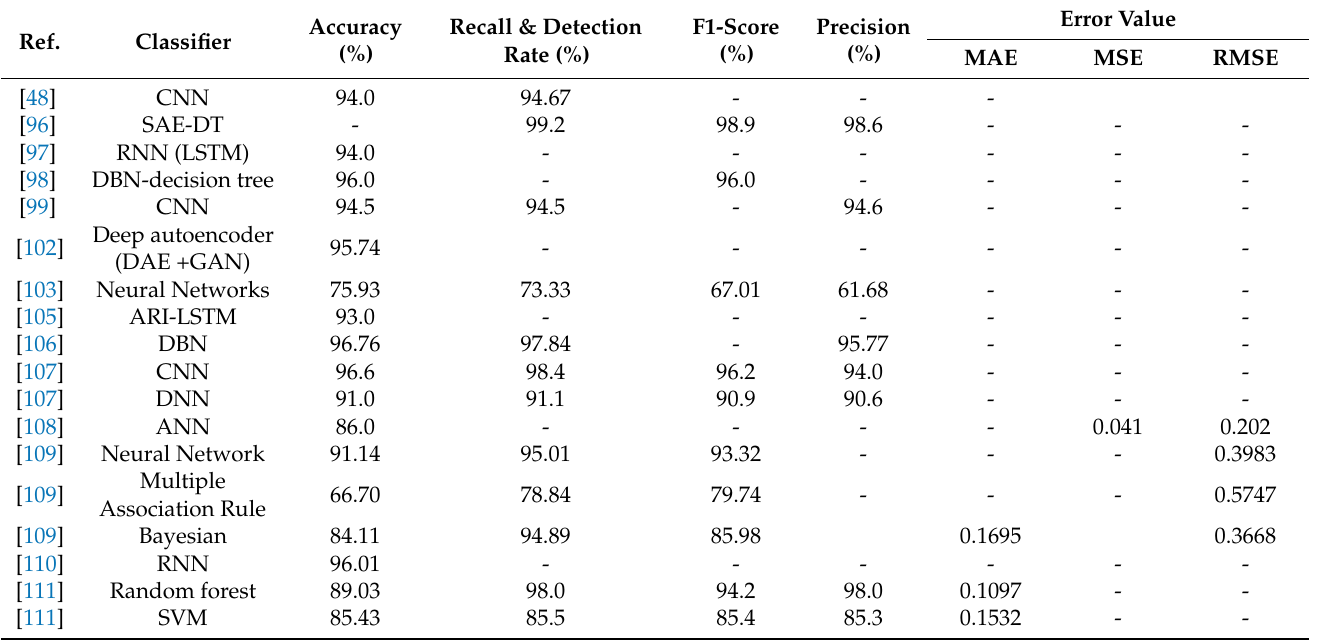
Table 8. Comparison of related works on DL for malware detection in IoT based on number of parameters.